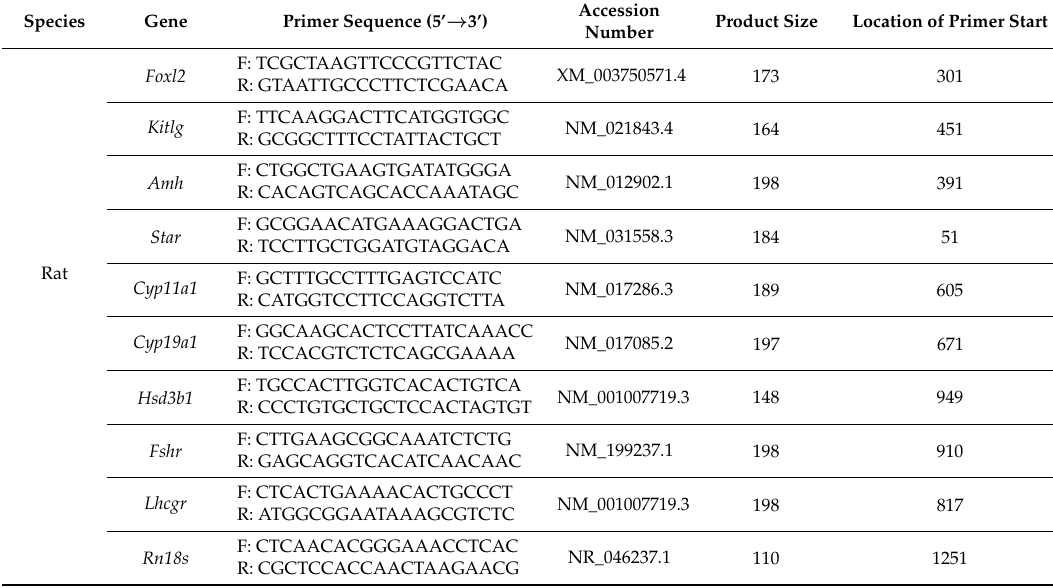
Table 1. Oligonucleotide sequences for quantitative real-time